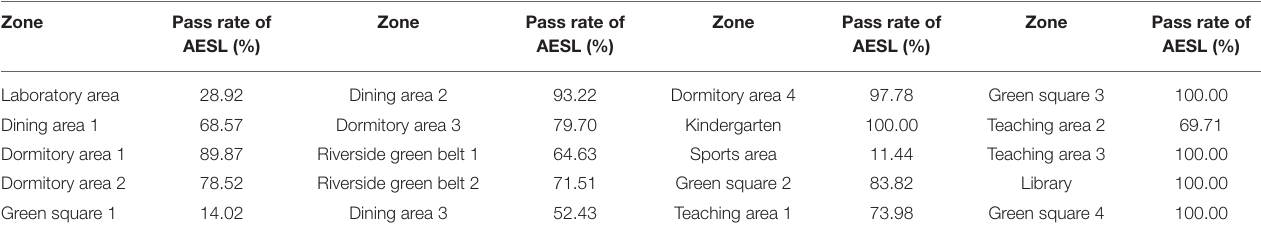
TABLE 4 | Pass rate of Average Equivalent Sound Level (AESL) in each zone.